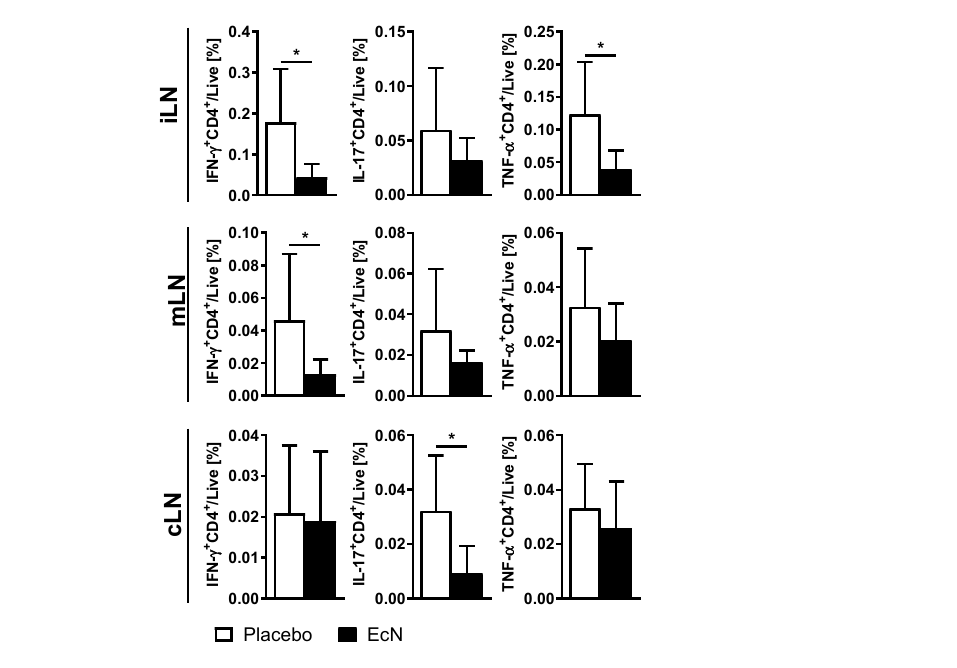
Figure 7. Live EcN increases the expression of some anti-microbial peptides in the gut at day 28 post-induction. Data are pooled from 5 independent experiments (in total: n = 25 (placebo) or 27 (EcN)) and differences were quantified by unpaired Mann–Whitney test; * p < 0.05. 3.6. Live EcN Decreases the Proportion of Classically Activated Macrophages To assess myeloid and B cell status after EcN treatment, mice treated by the preven- tive plus treatment schedule (see Figure 1) were assessed on day 28. There were no differ- ences between the groups in the proportion of monocytes/macrophages overall in the mLN between EcN-treated and placebo-treated mice by flow cytometry in the mLN of EcN-treated mice than control mice. However, we observed a significantly lower propor- tion of inducible nitric oxide synthase (iNOS) + macrophages (putative M1 macrophages) in the EcN-treated mice. Interestingly, these differences were not observed in the cLN draining the eye (Figure 8). Furthermore, there were no differences between the groups in the proportion of neutrophils or B cells in either lymph node set. The interactions be- tween CD40 on the B cell and the CD154 on the T cell have multiple consequences for both types of cells [46]. However, there were no differences in CD40 expression between B cells